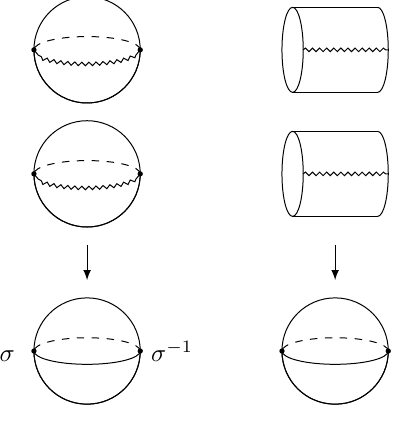
Figure 7 . The (cid:12)gure on the left shows a term in the Gross-Taylor expansion corresponding to a two-sheeted branched covering of the sphere with two (cid:10)-point singularities. These two (cid:12)xed points on the target sphere are labelled by the permutation (cid:27) : 1 interchanges the two sheets. On the right, we have opened up each branch point on the covering space into a single connected boundary, representing an external closed string state given by In the open string channel, this is interpreted as a (cid:12)nite temperature loop diagram in which an open string anchored on the (cid:10)-points winds twice around the